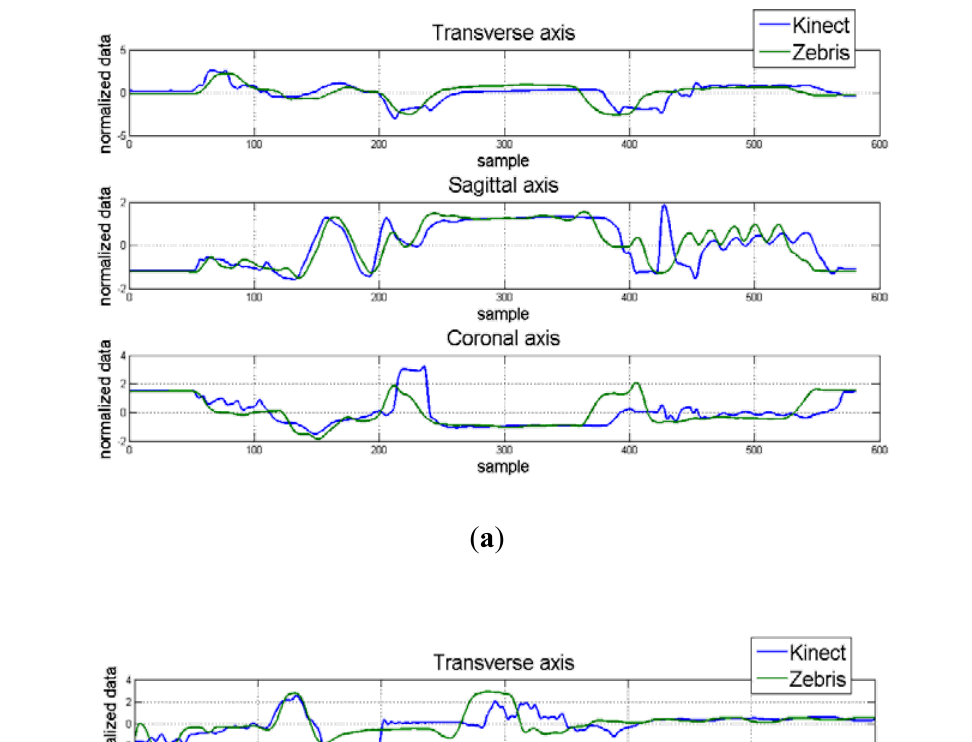
Figure 7. Comparison of position data for the Kinect (blue lines) and the Zebris system (green lines) from a single tea making task trial for the control ( a ) and the apraxic ( b )